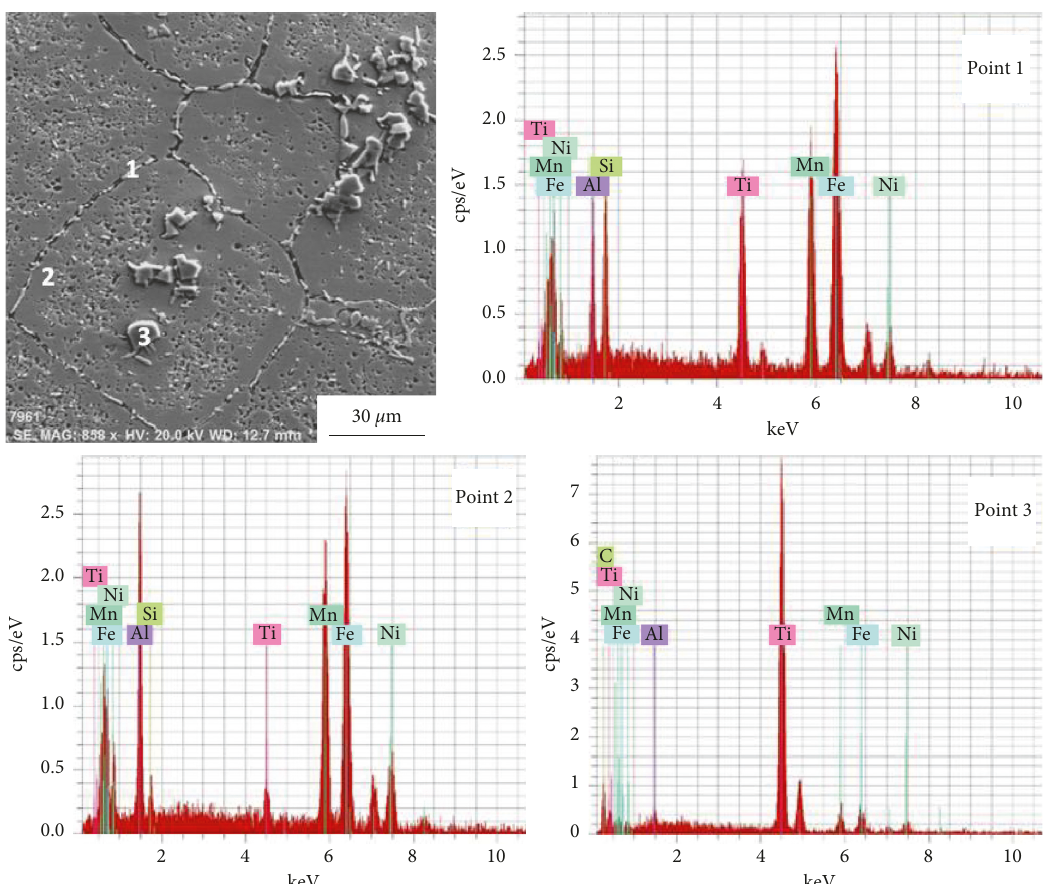
Figure 10: SEM and the corresponding point analysis at different positions for the C3 sample after heat treatment at 900 ° C for 10h.